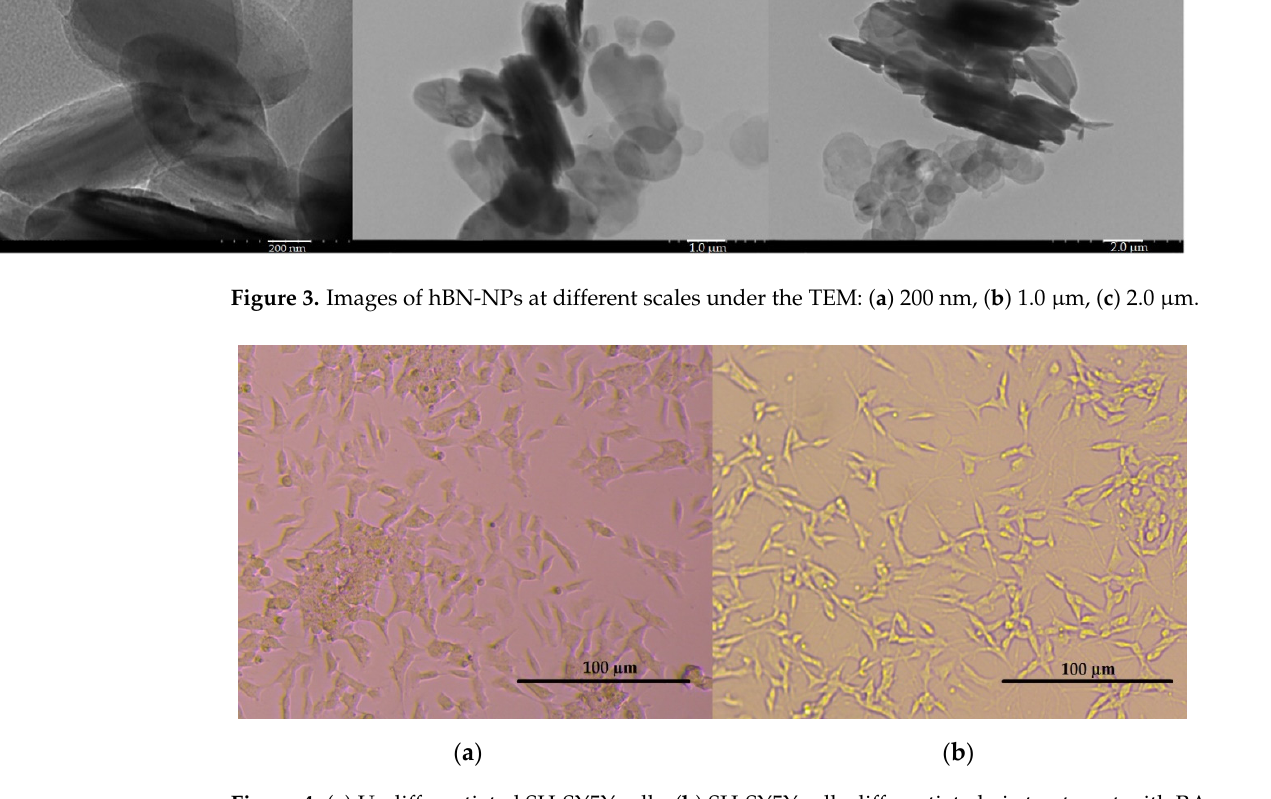
Figure 4. ( a ) Undifferentiated SH-SY5Y cells; ( b ) SH-SY5Y cells differentiated via treatment with RA.